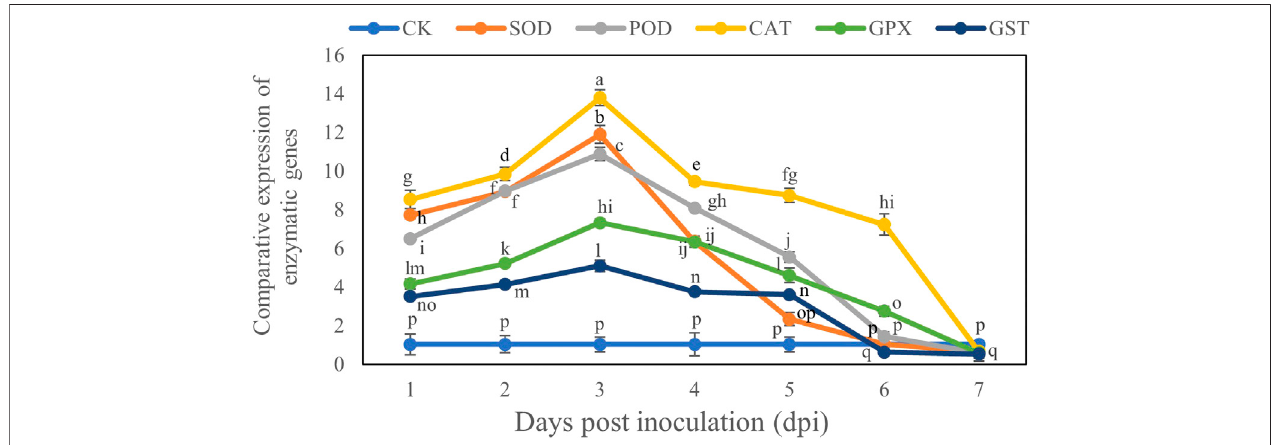
FIGURE 6| Comparative study of expression of antioxidant enzyme genes in B. brassicae inoculated with T. longibrachiatum T6 at different time points (1 – 7 days) post-inoculation. Different letters represent the signi fi cant difference at the p < 0.05 level by Duncan ’ s new multiple range test. The line bars represent means ± standard